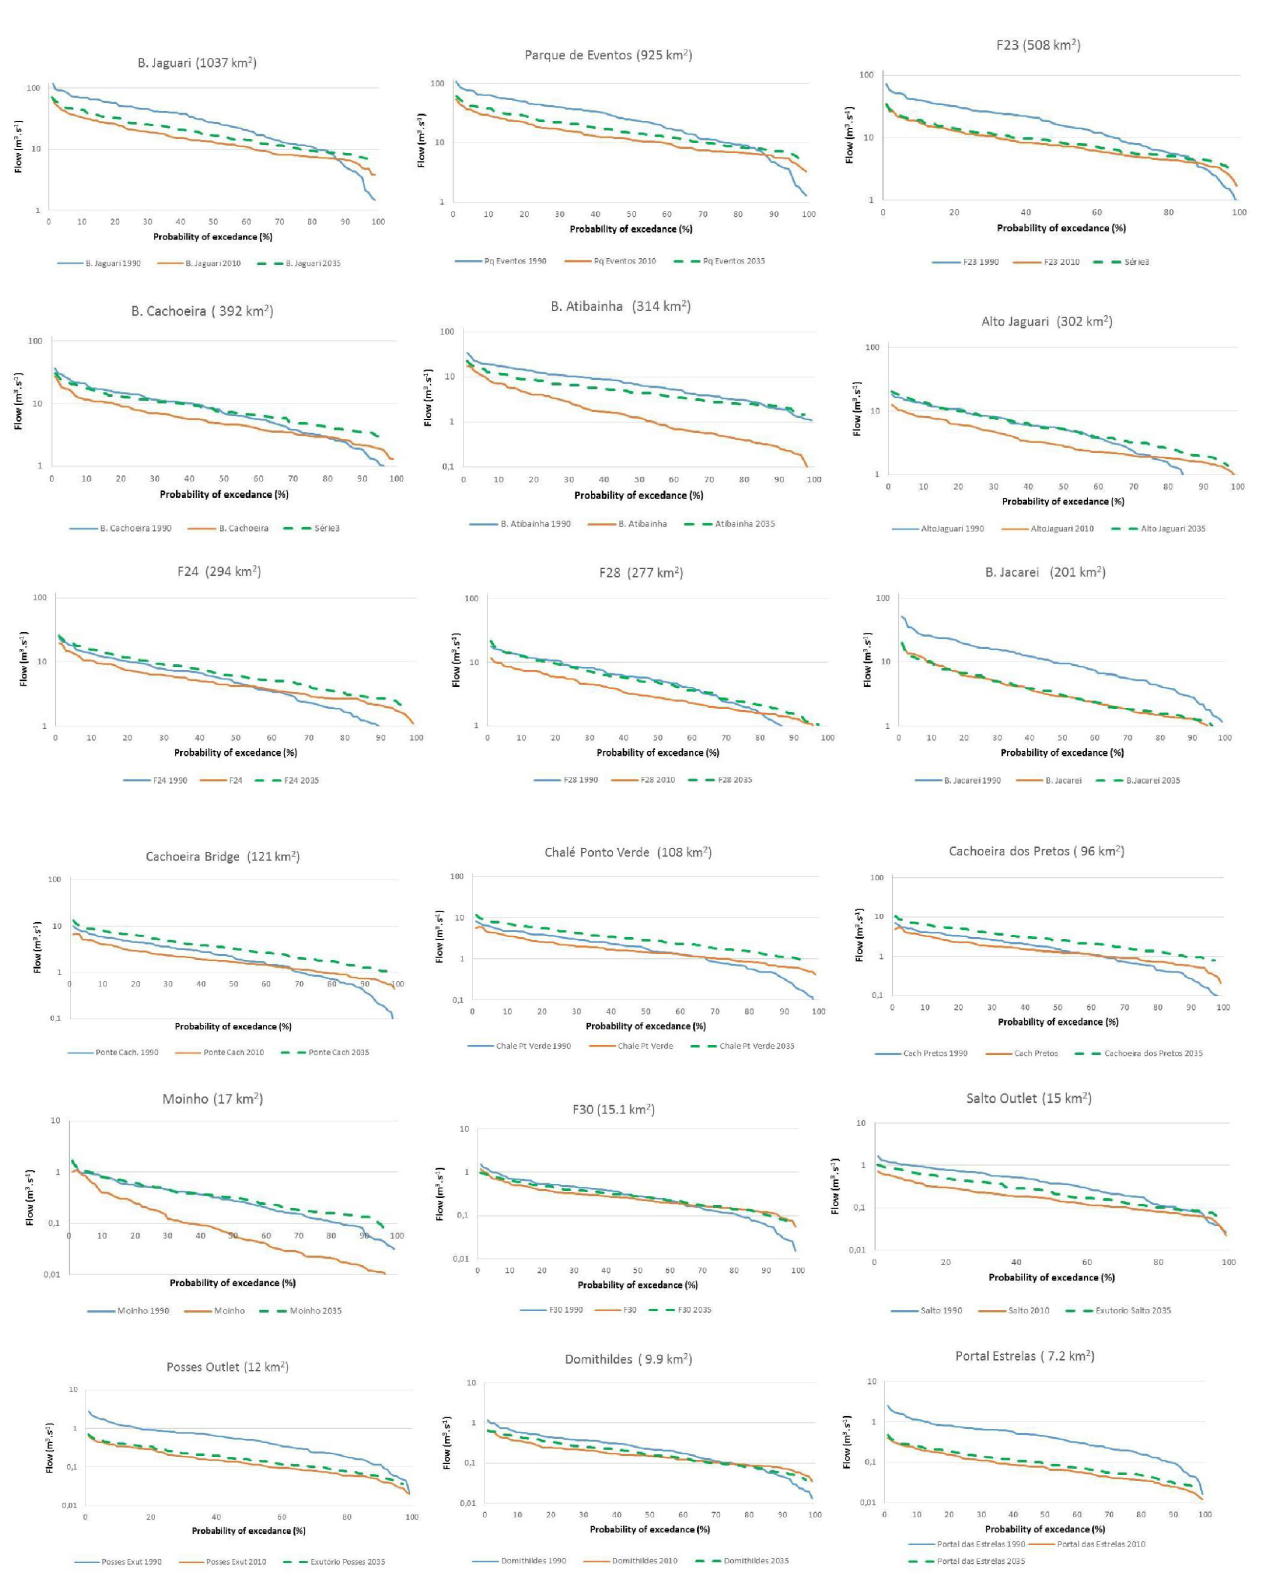
Figure 10. Flow duration curves under three LULC scenarios: S1(1990), S2(2010) and S2 + EbA(2035) at headwaters of the Cantareira water supply